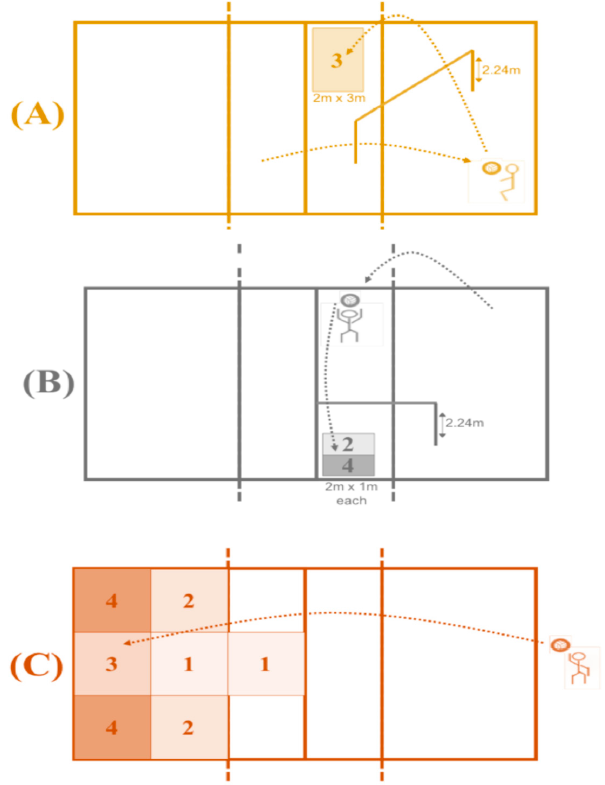
Figure 1. Test designs for the three volleyball skills including scores. Each sub-test corresponds to one skill: ( A ) underhand pass, ( B ) overhand pass, and ( C ) overhand service [48]. The numbers correspond to the scores given when the ball landed in this area.